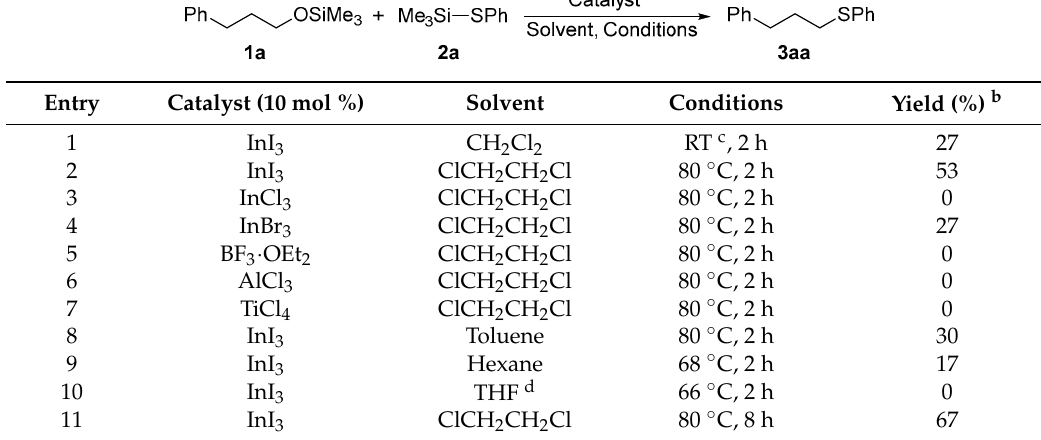
Table 1. Optimization of conditions in the reaction of silyl ether 1a with thiosilane 2a. a